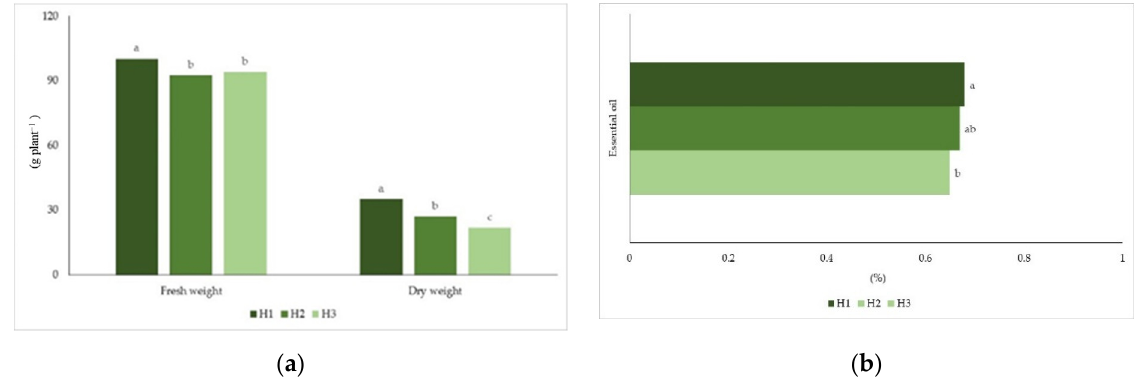
Figure 6. Effect of plant habitus on production characteristics of rosemary biotypes. Graph ( a ) refers to effect of plant habitus on fresh and dry weight, while graph ( b ) refers to effect of plant habitus on essential oil. Means followed by the same letter are not significantly different for p ≤ 0.05 according to Tukey’s